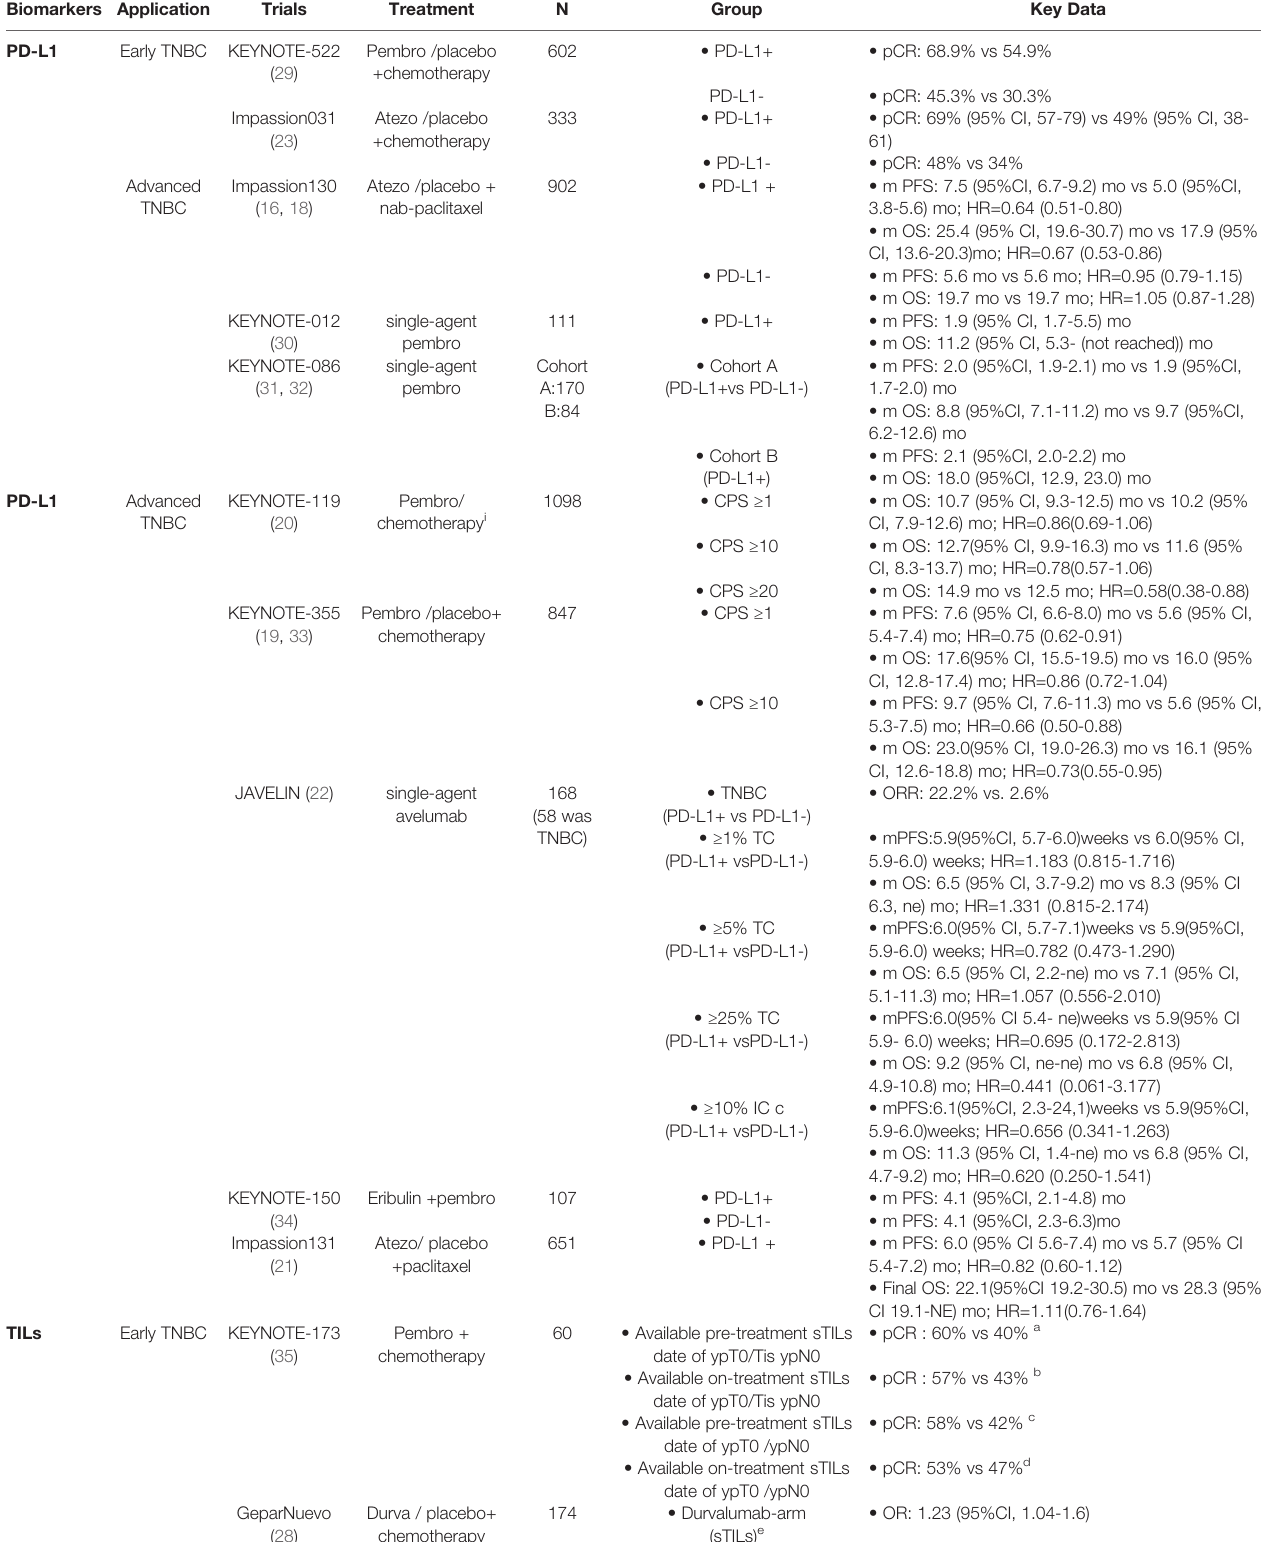
TABLE 1 | Summary of clinical trials evaluating the predictive value of the biomarkers for ICIs in TNBC. Biomarkers Application Key